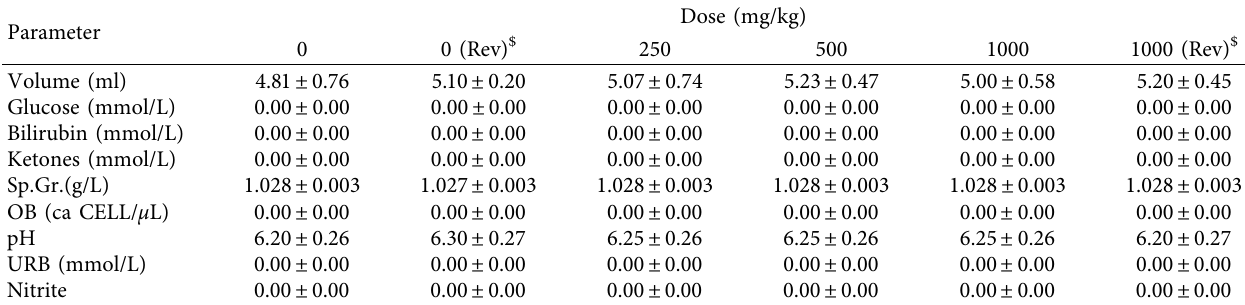
Table 7: Effect of GutGard on urine parameters of male rats during 90 D oral toxicity study.